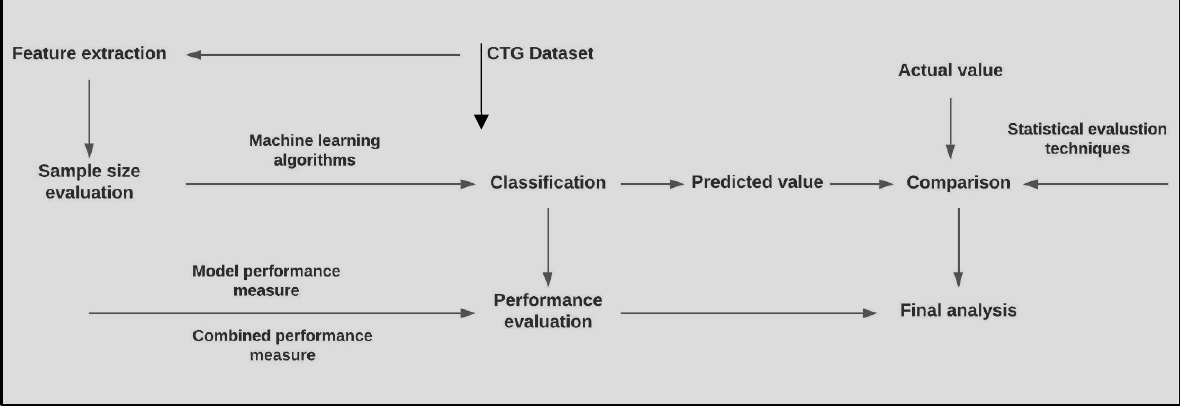
Figure 1. Overview of the proposed methodology.